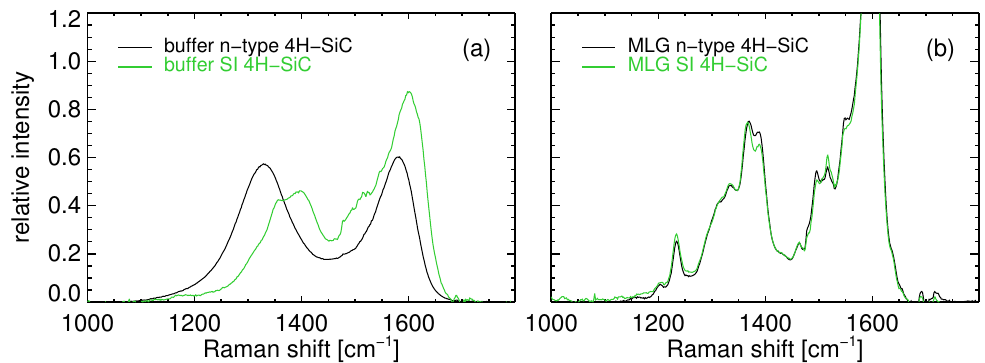
Figure 5. A comparison between the average µ -Raman scattering spectra for buffer layer samples with T Ar = 800 ◦ C: ( a ) on n-type and SI 4H–SiC, and ( b ) the buffer layer features in fully-formed MLG at T Gr = 2000 ◦ C for 0 s on n -type and SI 4H–SiC.